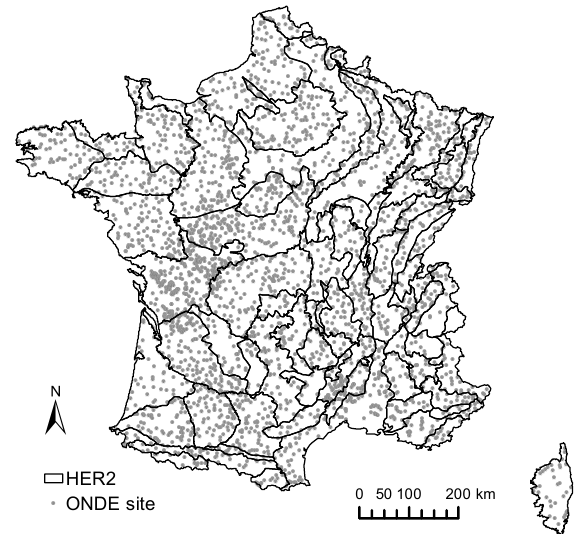
Figure 1. Location of the 3300 ONDE sites and partition into